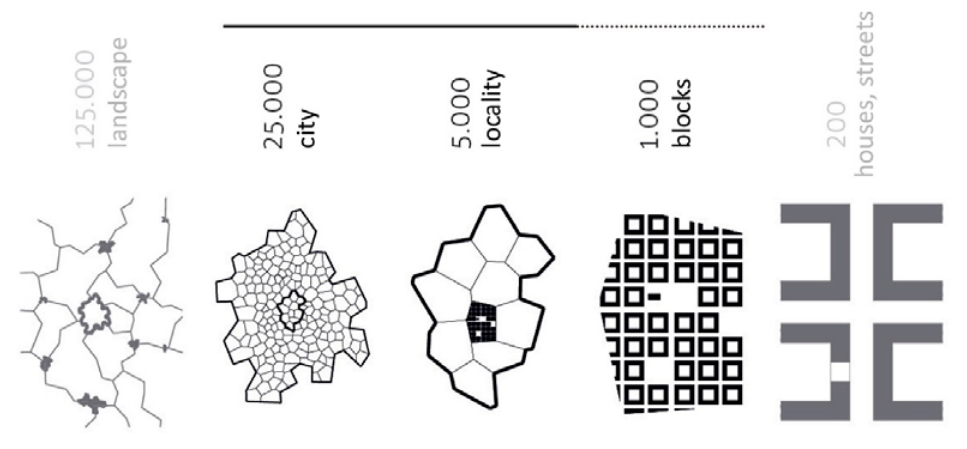
fig. 2. Scales of the Metropolitan